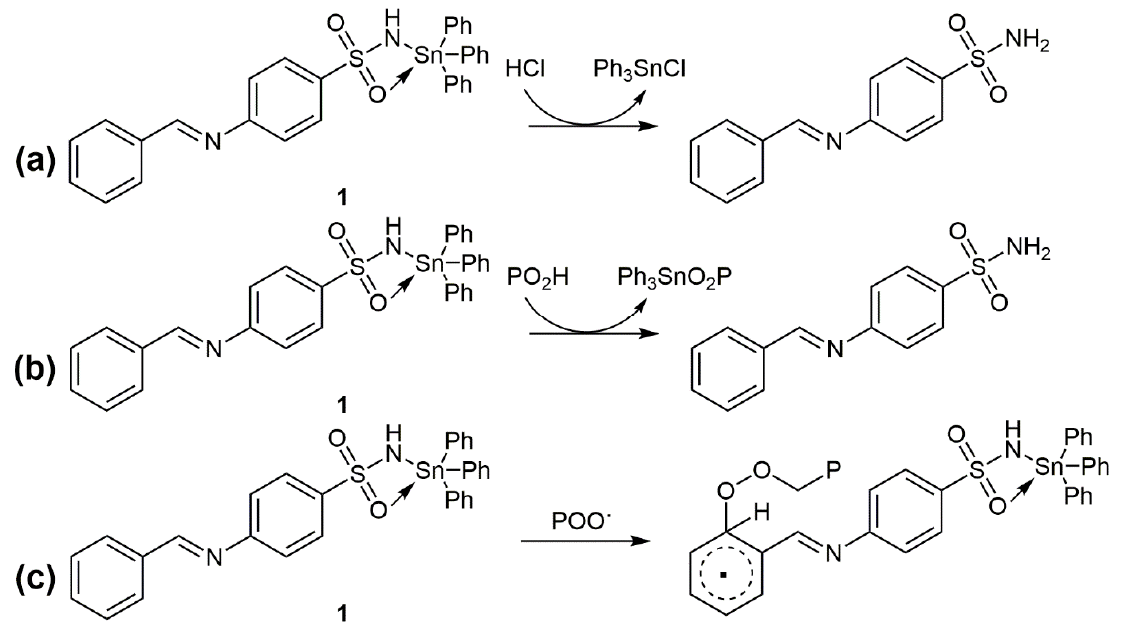
Figure 11. Complex 1 as ( a ) a HCl scavenger, ( b ) a PO 2 H decomposer, and ( c ) a radical scavenger.